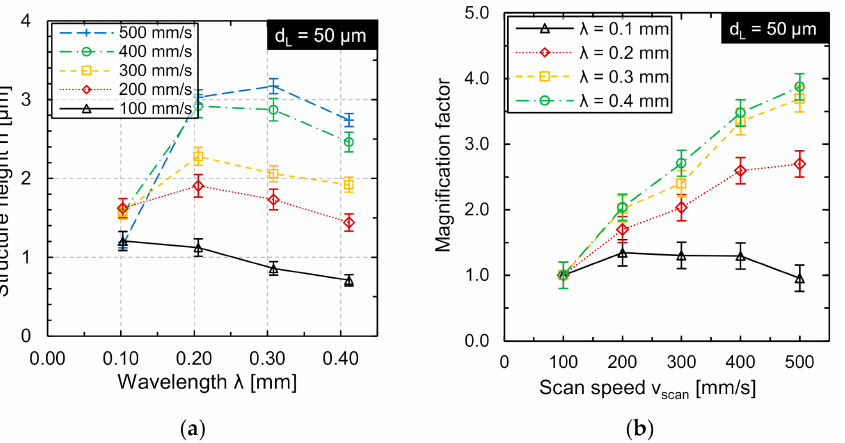
Figure 11. ( a ) Structure height h as function of scan speed v scan and adapted repetitions n ; ( b ) magni- fication of structure in comparison to the structure height achieved for the respective wavelength at v scan = 100 mm/s and n = 1 ( d L = 50 µ m, v scan = 200 mm/s, P M and P A adapted to v scan